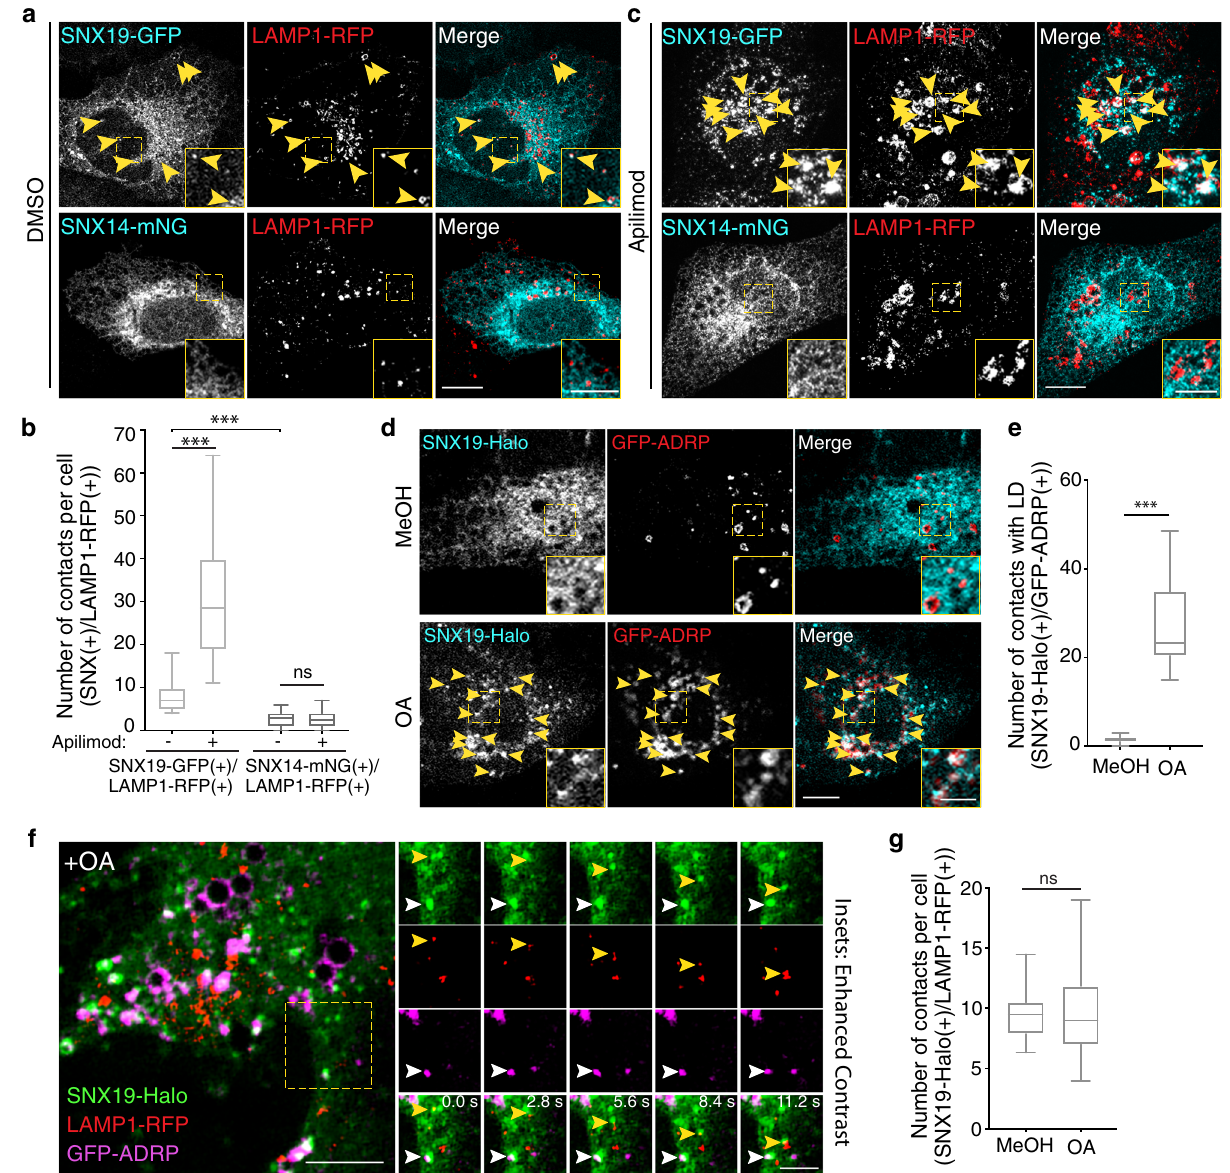
Fig. 7 SNX14 does not form contacts with endolysosomes. a U-2 OS cells co-transfected with plasmids encoding LAMP1-RFP and SNX19-GFP or SNX14- mNeonGreen (abbreviated mNG) were treated with DMSO for 2 h, fi xed and imaged by confocal microscopy. Arrowheads point to contacts of SNX19-GFP with LAMP1-RFP. Insets are magni fi ed views of the boxed areas. b Quanti fi cation of contacts in a and c . Box and whisker plots of data from 20 to 30 cells across 2 independent experiments. The box extends from 25th to 75th percentiles, the horizontal line represents the median, and the whiskers represent the minimum and maximum values. Statistical signi fi cance was calculated using the Mann – Whitney test; *** two-tailed p -value < 0.001, ns: not signi fi cant. c U-2 OS cells co-transfected as in a were treated with 200 nM apilimod for 2 h, fi xed, and imaged by confocal microscopy. Arrowheads point to contacts of SNX19-GFP with LAMP1-RFP. Insets are magni fi ed views of the boxed areas. d U-2 OS cells co-transfected with plasmids encoding SNX19-Halo (labeled with Janelia Fluor 646 dye) and the LD marker GFP-ADRP were treated with either methanol (MeOH) as a vehicle control (top panel) or 200 μ M oleic acid (OA) (bottom panel) for 2 h, and imaged live by confocal microscopy. Arrowheads point to contacts of SNX19-Halo with LDs. Insets are magni fi ed views of the boxed areas. e Quanti fi cation of SNX19-Halo – GFP-ADRP contacts under conditions in d . Box and whisker plots represent data from 3 independent experiments, 10 cells per condition, per experiment. Statistical signi fi cance was analyzed by the Mann – Whitney test; *** two-tailed p -value < 0.001. f U-2 OS cells co-transfected with plasmids encoding SNX19-Halo (labeled with Janelia Fluor 646 dye), LAMP1-RFP, and GFP-ADRP, were treated with oleic acid (OA) as in d , and imaged live by confocal microscopy. Small images are frames from a video with the individual and merged channels cropped from the dashed box over time. Yellow arrows: SNX19-Halo – LAMP1-RFP contacts, White arrows: SNX19-Halo – GFP-ADRP contacts. g Quanti fi cation of SNX19- Halo – LAMP1-RFP contacts in experiments described in f where control cells are those treated with MeOH. Box and whisker plots represent data from 3 independent experiments, 6 – 18 cells imaged per condition, per experiment. A two-sided Mann – Whitney test was used to analyze statistical signi fi cance; ns: not signi fi cant. For plots in b , e , g , box extends from 25th to 75th percentiles, the horizontal line represents the median, and the whiskers represent the minimum and maximum values. Source data are provided as a Source Data fi le. Scale bars: 10 μ m, 5 μ m